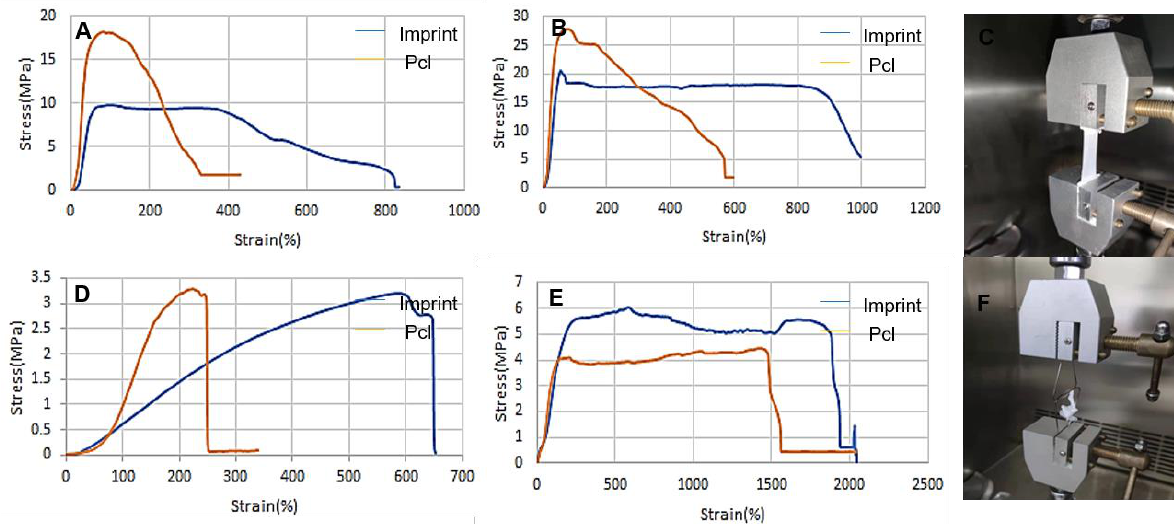
Figure 3. Tensile mechanics test: ( A ) is the drawing of the imprinted film and the pcl direct writing composite film in the vertical groove direction. The tensile strength of the composite stent is 18.154 MPa, and the tensile strength of the imprinted stent is 9.800 Mpa. ( B ) is the drawing of the imprinted film and the pcl direct-writing composite film stretching in the direction of the groove, the tensile strength of the composite stent is 27.784 MPa, and the tensile strength of the imprinted stent is 20.516 Mpa. ( C ) is the film tensile test graph. ( D ) is the drawing of the embossed tubular sample and the pcl direct-write composite tubular sample in the radial direction. The tensile strength of the composite stent is 3.279 MPa, and the tensile strength of the imprinted stent is 3.189 Mpa. ( E ) is the embossed tube. The sample and pcl direct-write composite tubular sample stretched along the axial direction, the tensile strength of the composite stent was 4.476 MPa, and the tensile strength of the imprinted group stent was 6.026 Mpa ( F ) for the tubular tensile experiment.